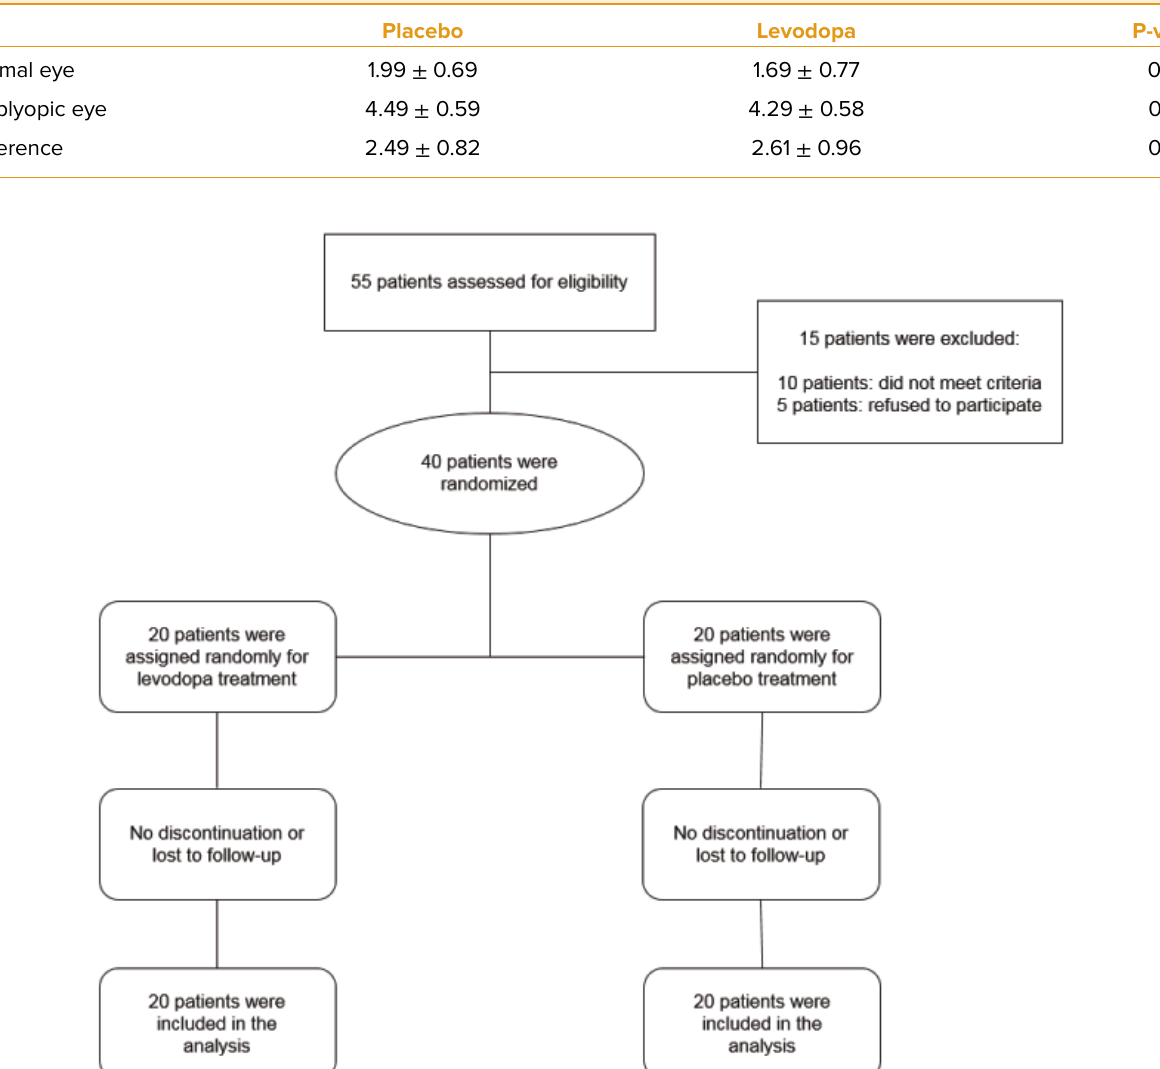
Table 1. Absolute refractive errors of both groups and differences in refractive errors (mean and standard deviation of the spherical equivalent of anisometropia in both groups)